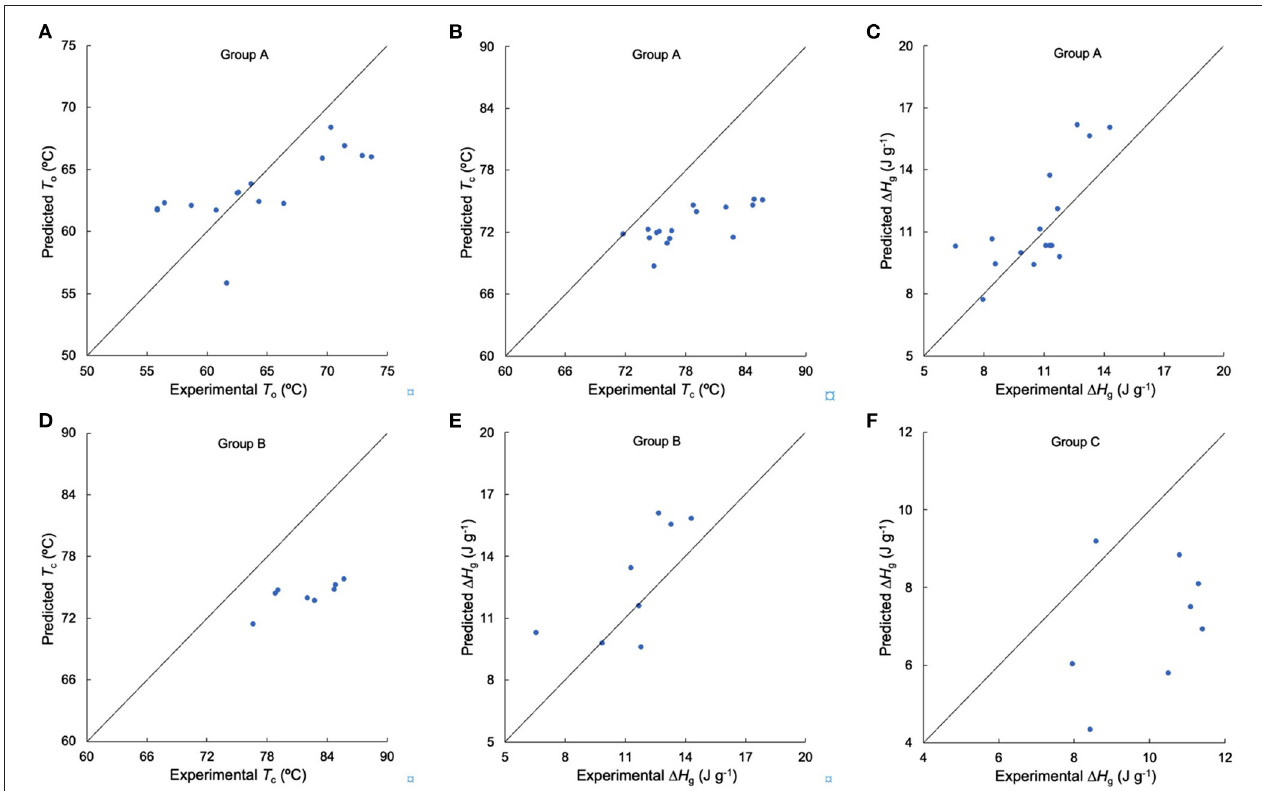
FIGURE 5 | Testing the suitability of linear regression models for thermal properties. (A–C) Comparison of experimental and predicted T o , T c , and 1 H g from Group A, respectively, (D,E) comparison of experimental and predicted T c , and 1 H g from Group B, respectively, (F) comparison of experimental and predicted 1 H g from Group C. Samples DR S24–S31 and S32–S39 were used in Group A, samples DR S24–S31 were used in Group B, and samples DR S32–S39 were used in Group